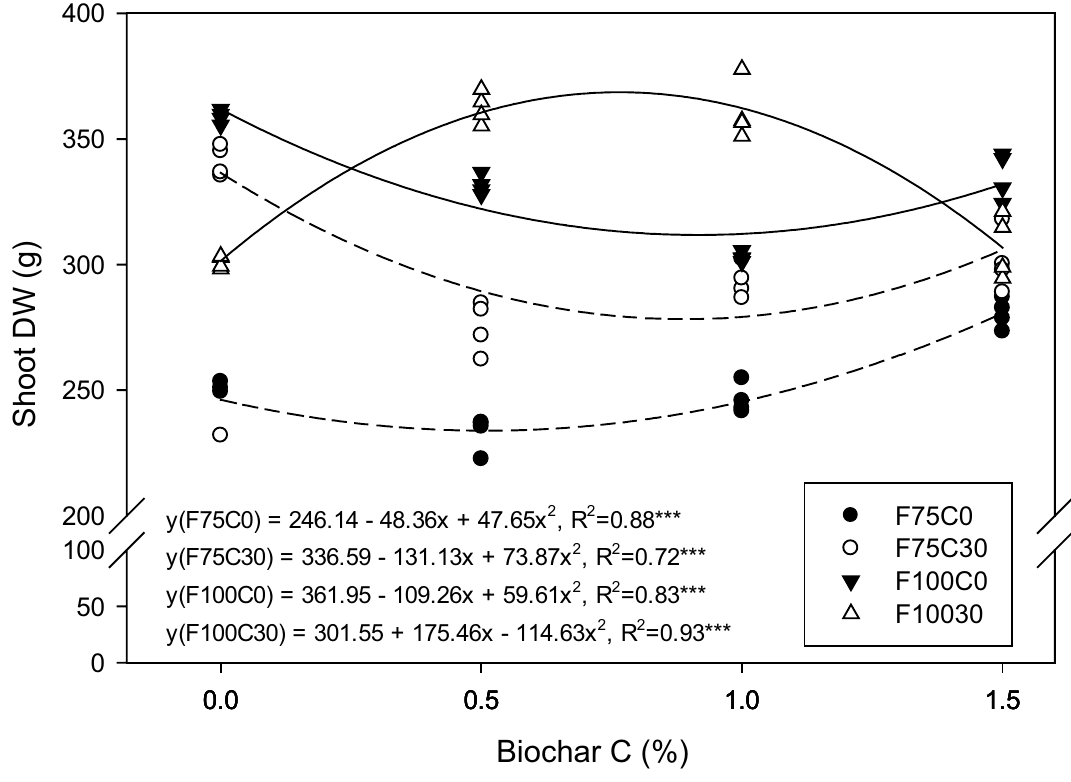
Fig. 2 Shoot dry weight of oil palm seedling as affected by fertiliser recommended rates (75 and 100%) and biochar rates (0, 0.5, 1.0 and 1.5% biochar C) in media without and with compost treatment (0 and 30% v/v). Asterisk symbols indicates a significant regression trend at *** P ≤ 0.001, ( n = 4). Notes: F75C0 75% fertiliser recommended